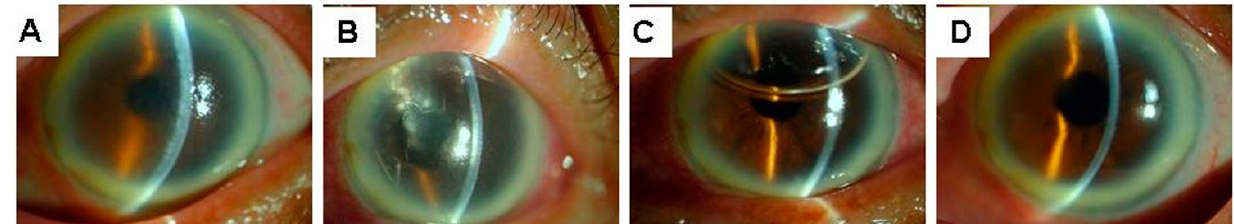
Figure 4. Representative clinical course of descemetopexy. Severe corneal edema ( A ) was found after phacoemulsification, and Descemet’s membrane detachment ( B ) was detected near the main corneal incision. 50% of the anterior chamber was filled with air ( C ) two days post-descemetope and cornea regained its transparency ( D ) two weeks post-descemetopexy.